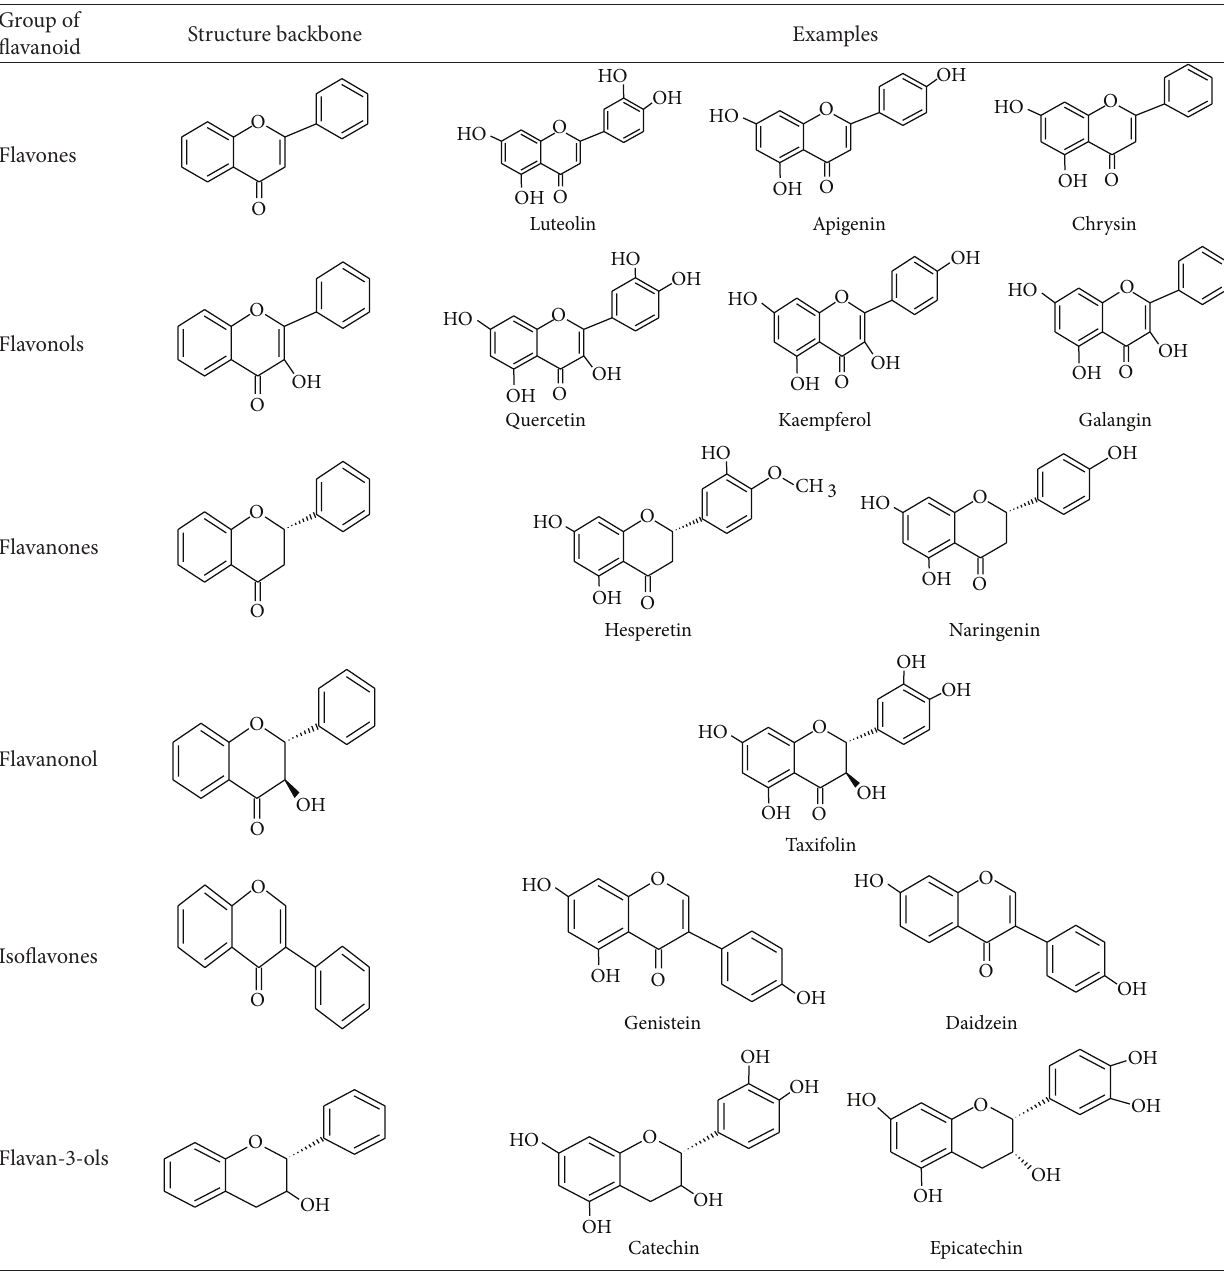
Table 1: Structure of